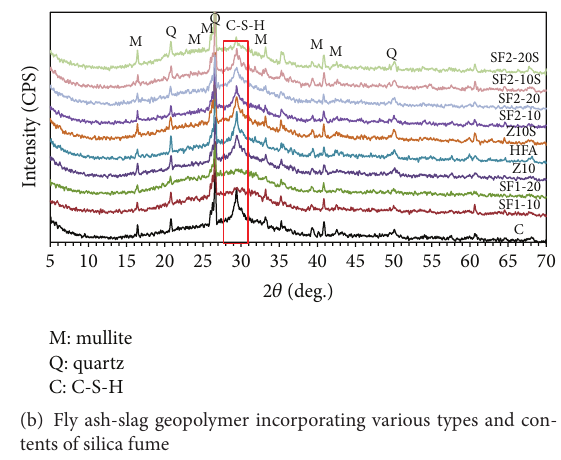
Figure 1: XRD patterns of raw materials and geopolymer incorpo- rating silica